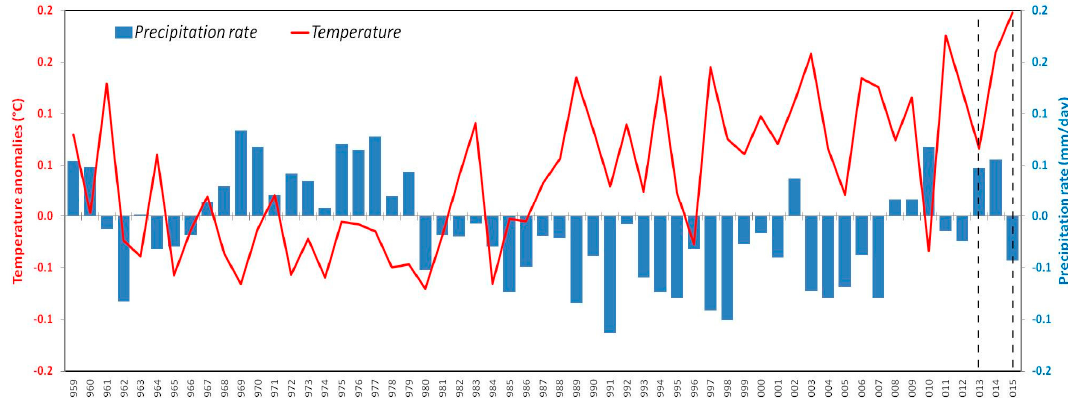
Figure 3. Inter-annual variability between 1959 and 2015 of annual average air temperature (°C) and precipitation rate (mm/day) at 850 hPa in the French Alps, which is roughly equivalent to 1500 m a.s.l.. Data were obtained from the NCEP-NCAR (National Centers for Environmental Prediction/National Center for Atmospheric Research). Anomalies were calculated based on the 1961–1990 average; the alpine regional index is approximately 5.5°–6.8°E/44.5°–46°N. Vertical dashed black lines indicate the years considered in our study (2013 and 2015).